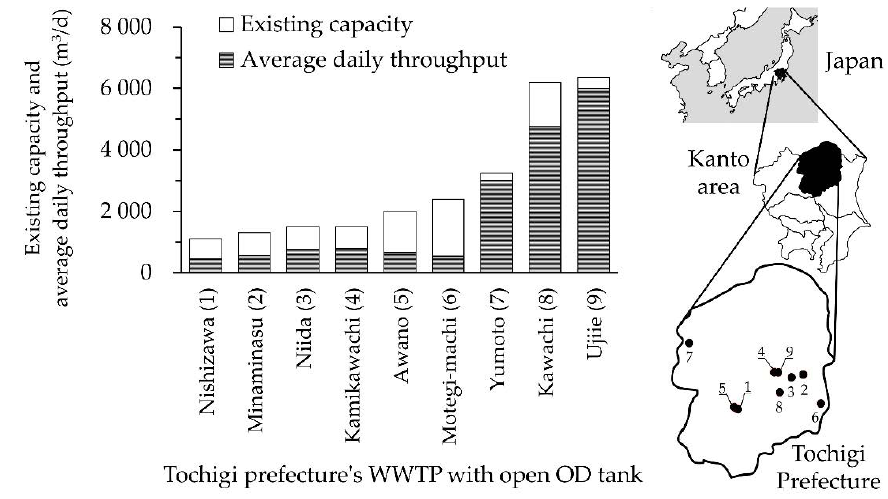
Figure 4. Facility utilization and locations of nine open-air (no cover) OD process WWTP in Tochigi Prefecture, Japan [14] (Map: Japanese GSI website).